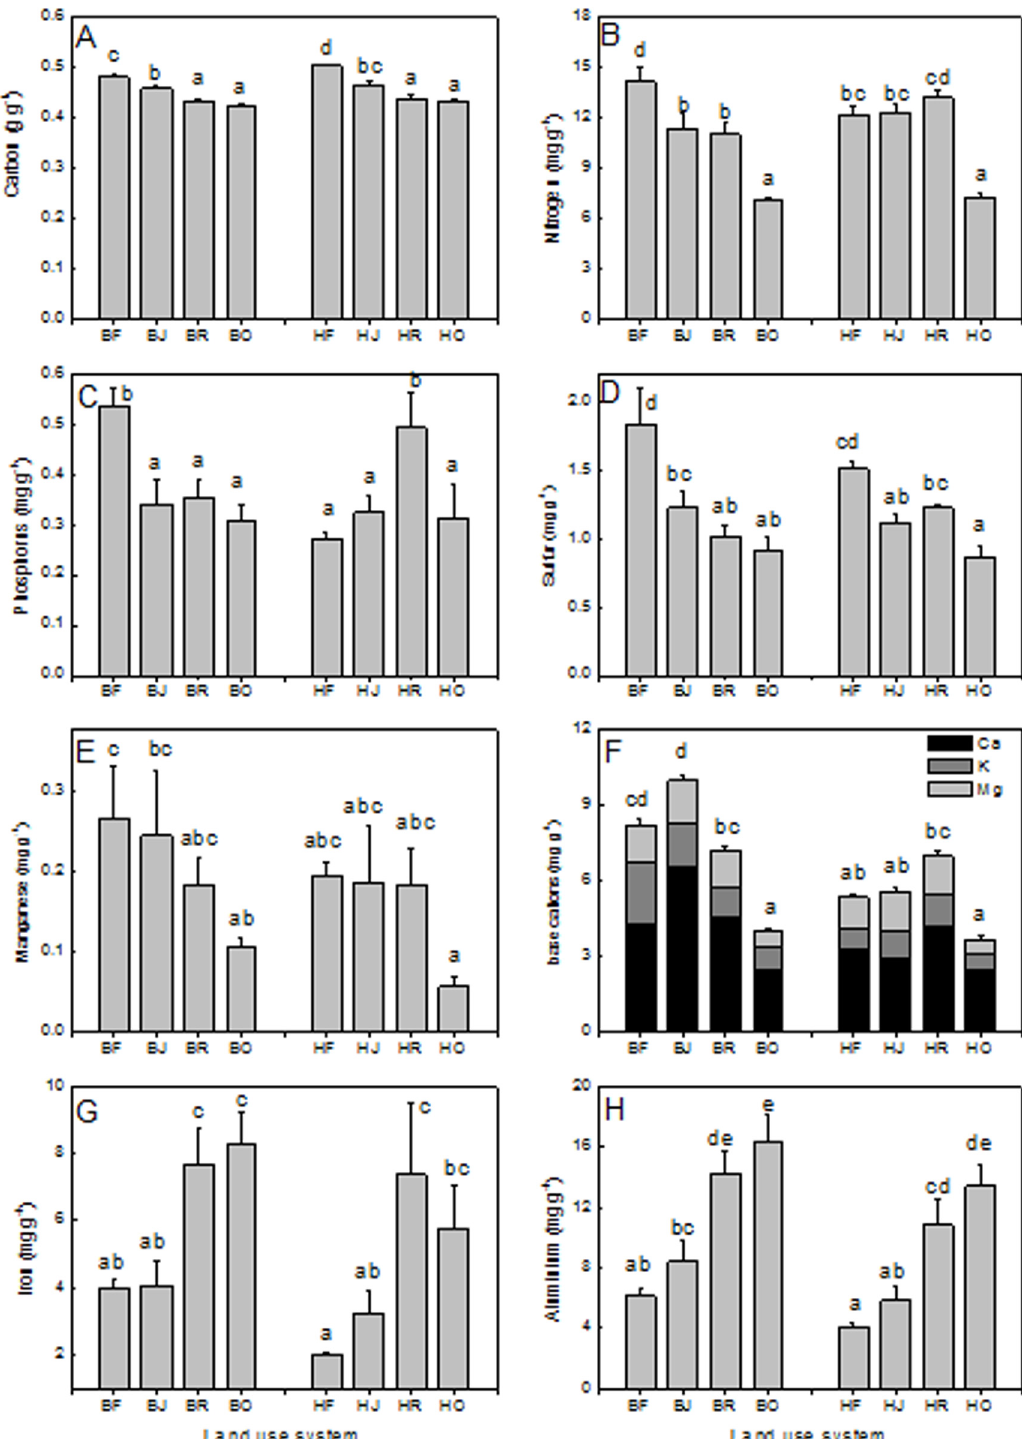
Fig 2. Chemical composition of roots in different land use systems. Carbon (A), nitrogen (B), phosphorus (C), sulfur (D), manganese (E), base cations (F), iron (G) and aluminium (H) determined as root community-weight traits. Data indicate means ( ± SE). Different letters indicate significant differences at P < 0.05. B = Bukit 12, H = Harapan, O = oil palm, R = rubber plantation, J = jungle rubber, F = forest.